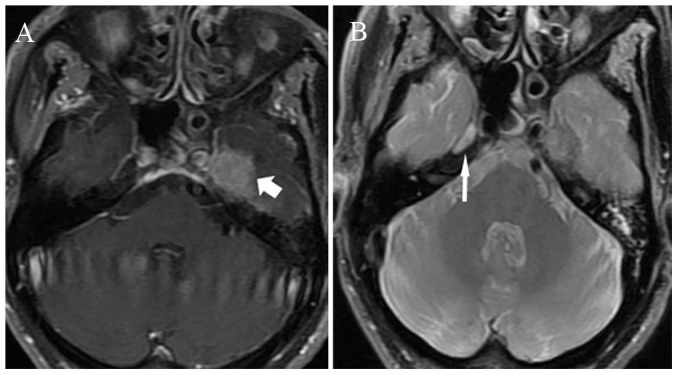
72-year-old man with nasopharyngeal carcinoma with cranial nerve invasion: (A) enhanced axial T1-weighted image with fat suppression shows the effacement of the left gasserian ganglion (short arrow); (B) axial PD weighted imaging shows the normal right gasserian ganglion (long arrow).